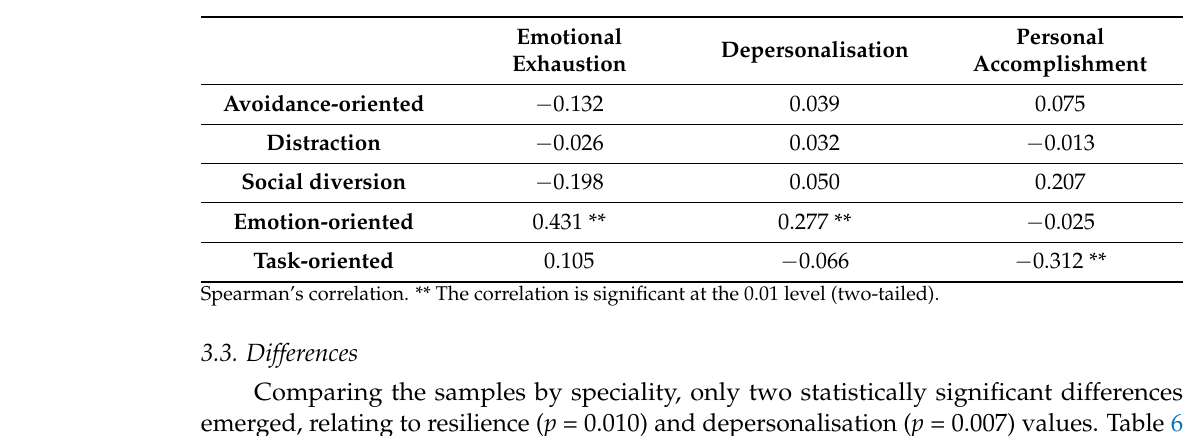
Table 5. Correlation between emotional exhaustion, depersonalisation, personal accomplishment and coping